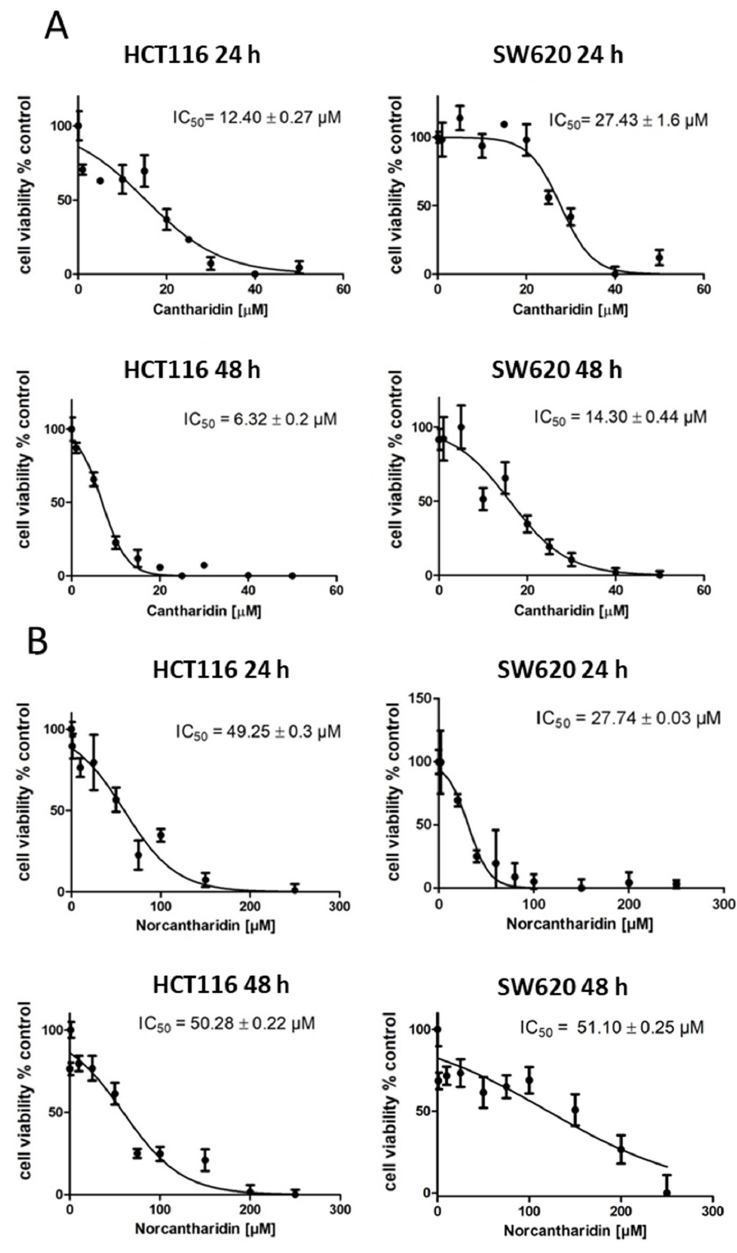
Figure 1. Assessment of cell viability measured using the MTT assay after 24 h and 48 h of treatment of increasing cantharidin or norcantharidin concentrations expressed as percent of DMSO control treated HCT116 or SW620 cells. The means and error bars represent three independent experiments. The IC 50 values were calculated by nonlinear regression analysis. ( A ) Effect of cantharidin on cell viability in HCT116 and SW620 cells. Top : 24 h treatment and bottom : 48 h treatment. HCT116 cells on the left side and SW620 cells on the right side. ( B ) Effect of norcantharidin on cell viability in HCT116 and SW620 cells. Top : 24 h treatment and bottom : 48 h treatment. HCT116 cells on the left side and SW620 cells on the right side.